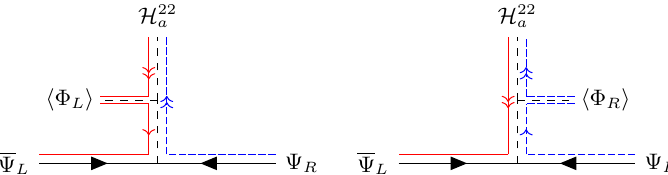
fields and result in the 2–2 a